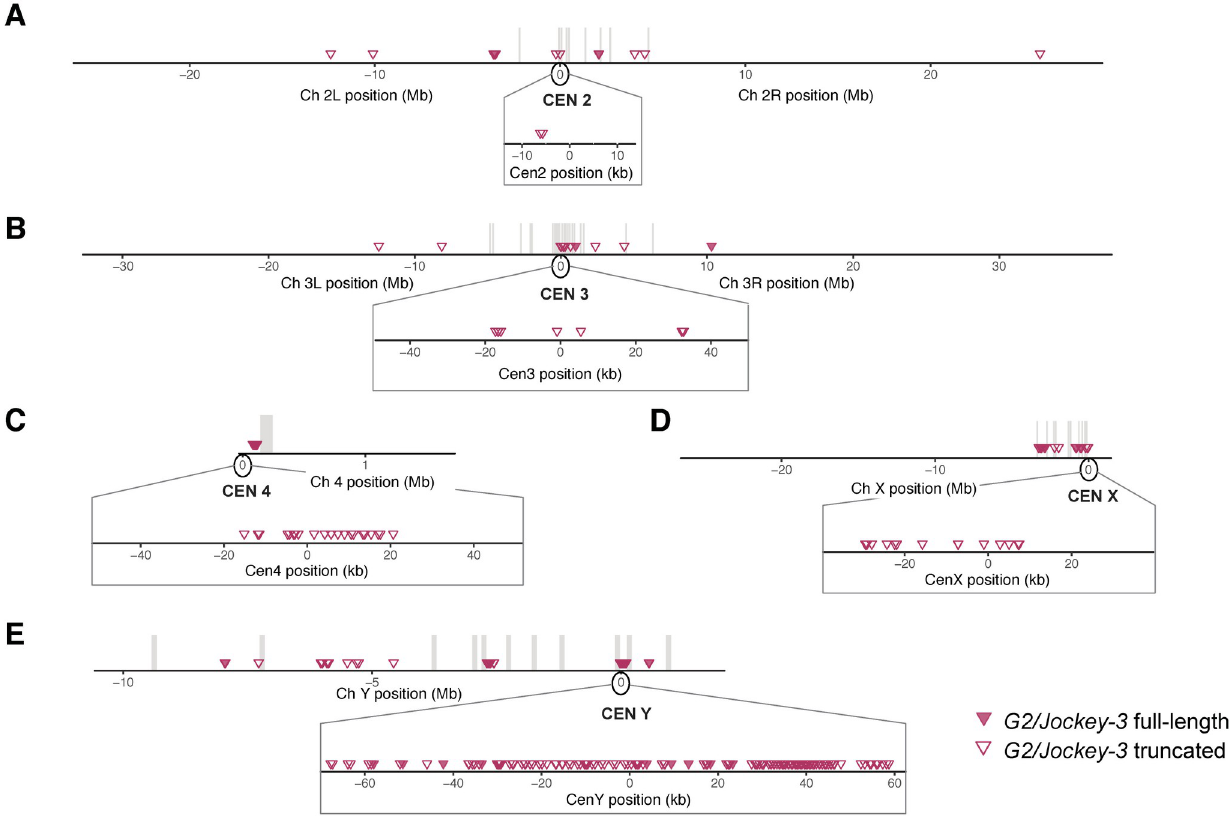
Fig 4. Genomic distribution of G2/Jockey-3 elements in the D . melanogaster genome. Location of G2/Jockey-3 elements across chromosome (“Ch”) 2 (A), 3 (B), 4 (C), X (D), and Y (E). Contigs from each chromosome were concatenated in order with an arbitrary insertion of 100 kb of “N.” Distances along the x-axis are approximate. The order and orientation of the Y chromosome contigs is based on gene order (see [19]). Each triangle corresponds to one TE, for which filled shapes indicate full-length TEs and open shapes indicate truncated TEs. The vertical gray bars represent the arbitrary 100-kb window inserted between contigs, indicating where there are gaps in our assembly. The centromere (“CEN”) positions are set to 0 for each chromosome. The insets zoom in to show the distribution of G2/Jockey-3 elements on the centromere contigs. Chromosomes are not drawn to scale (chromosome 4 and Y are enlarged). TE, transposable